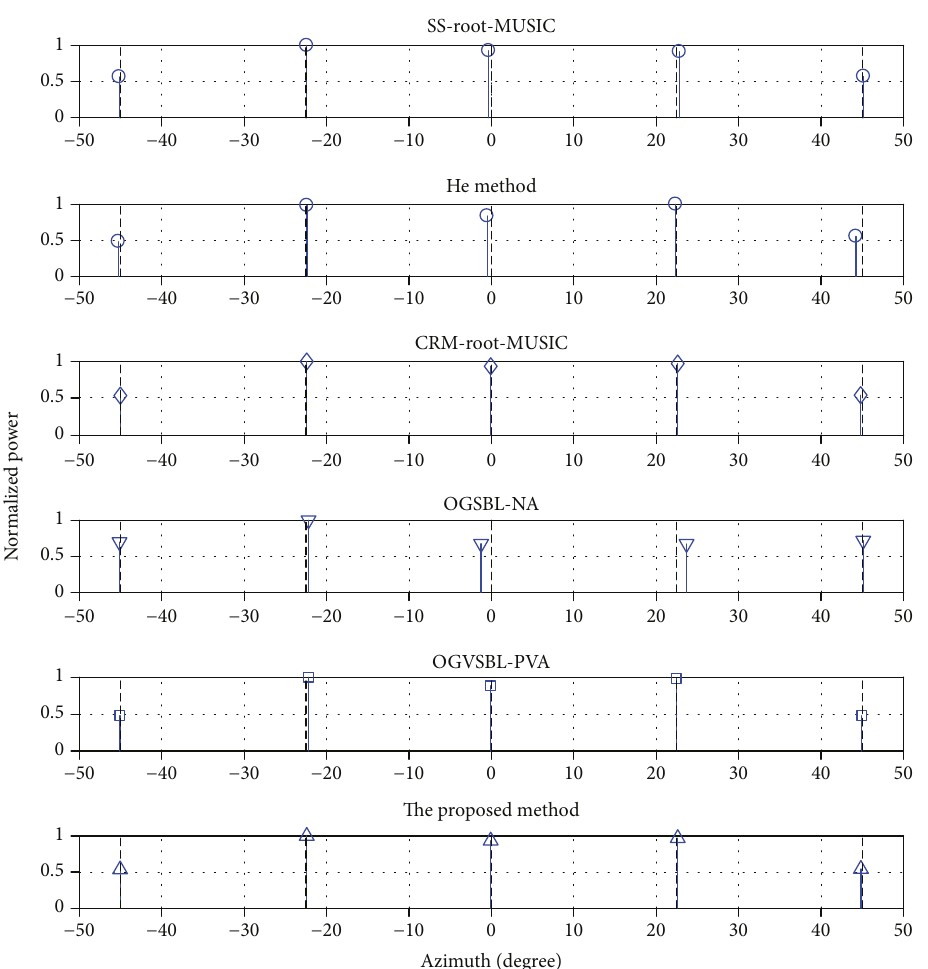
Figure 3: Normalized spatial spectra in nonuniform noise case for M = 6 , K = 5 , N = 500 , and SNR = 0dB